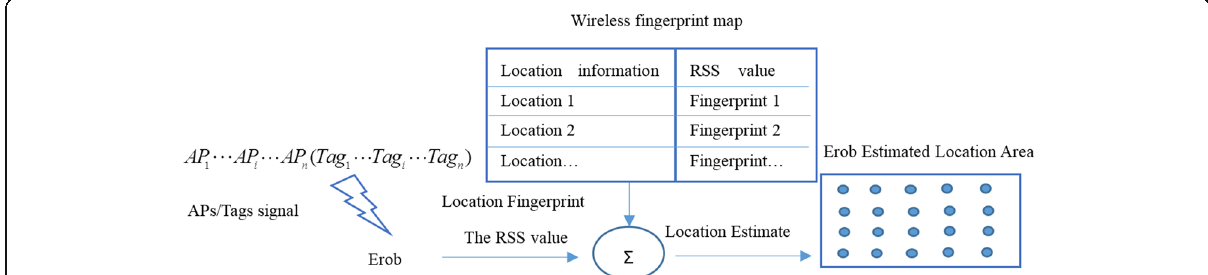
Fig. 2 Based on the fingerprint positioning technology of Erob online stage. Online phase: When Erob moves in the coverage area, real-time RSS is collected and matched with the RSS in the